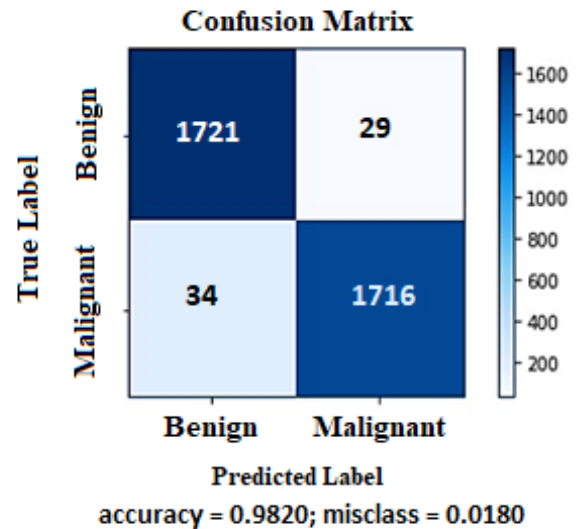
Figure 7. Confusion matrix of the MobileNetV2 model.